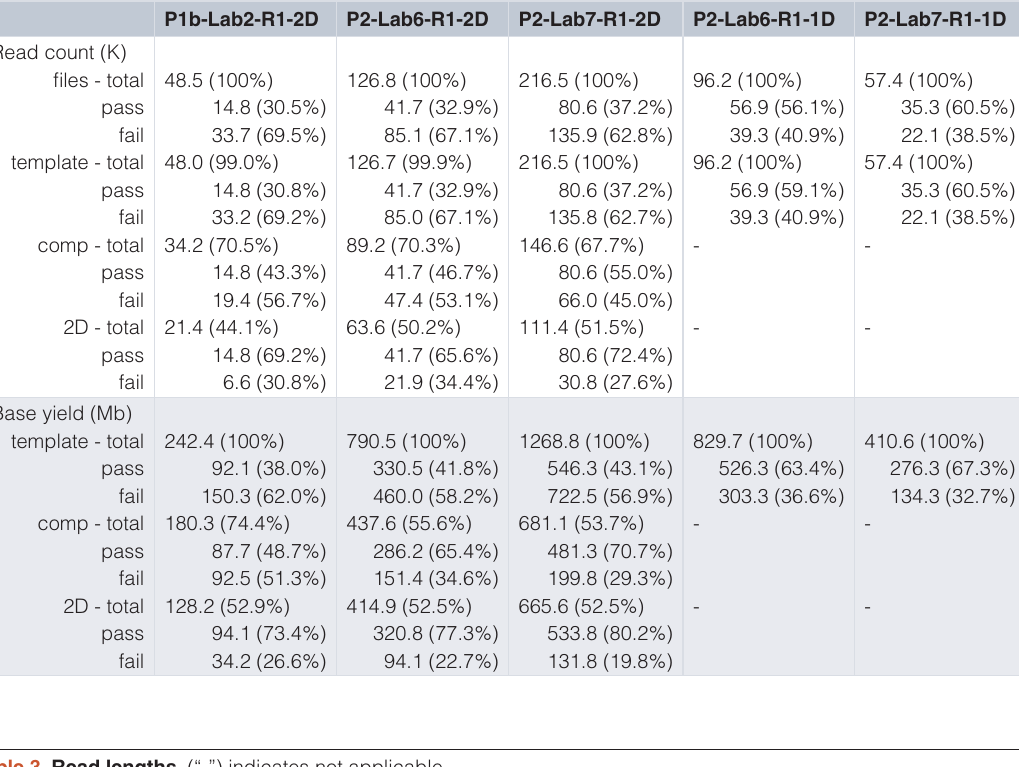
Table 3. Read lengths. (“-”) indicates not